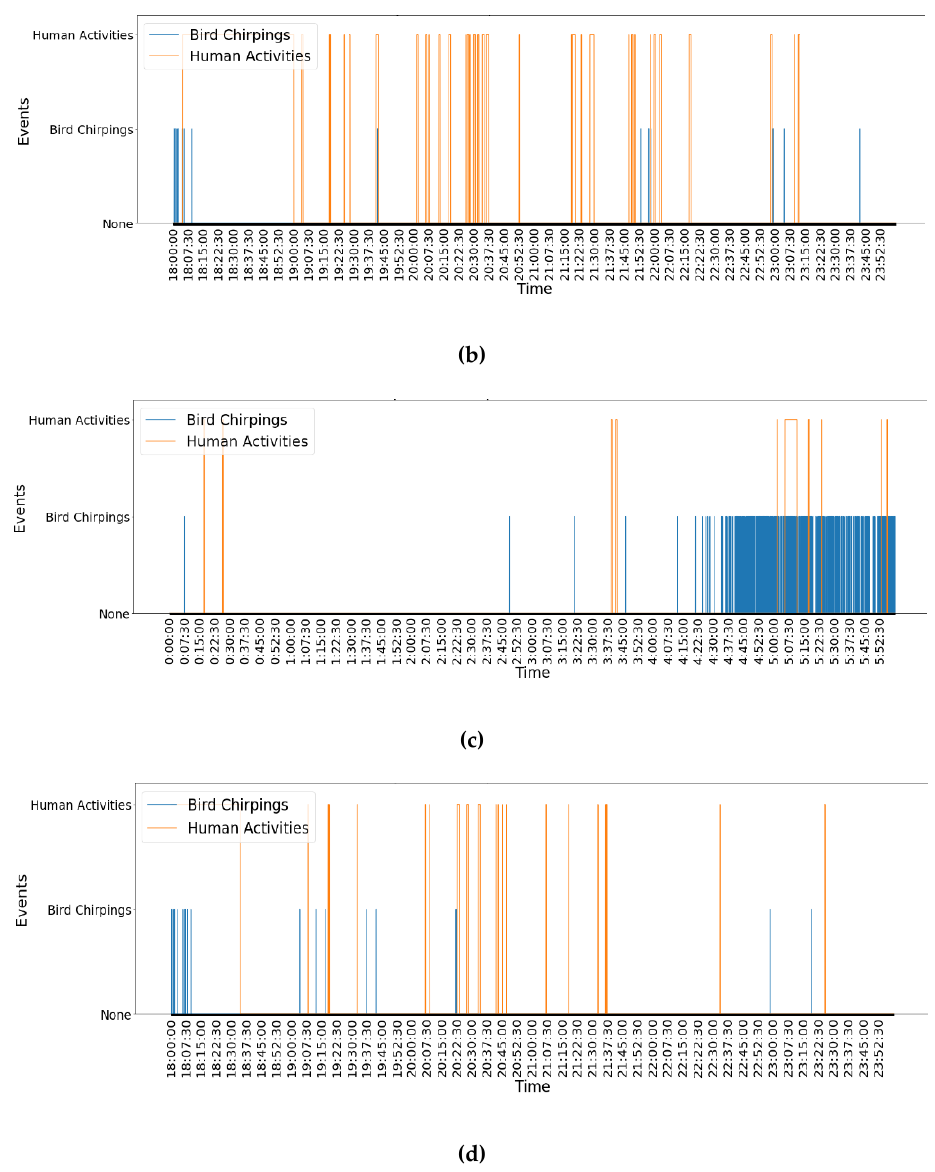
Figure 4. Graphic analysis. ( a ) Graphic analysis for NE20101013, 0–6:00:00; ( b ) Graphic analysis for